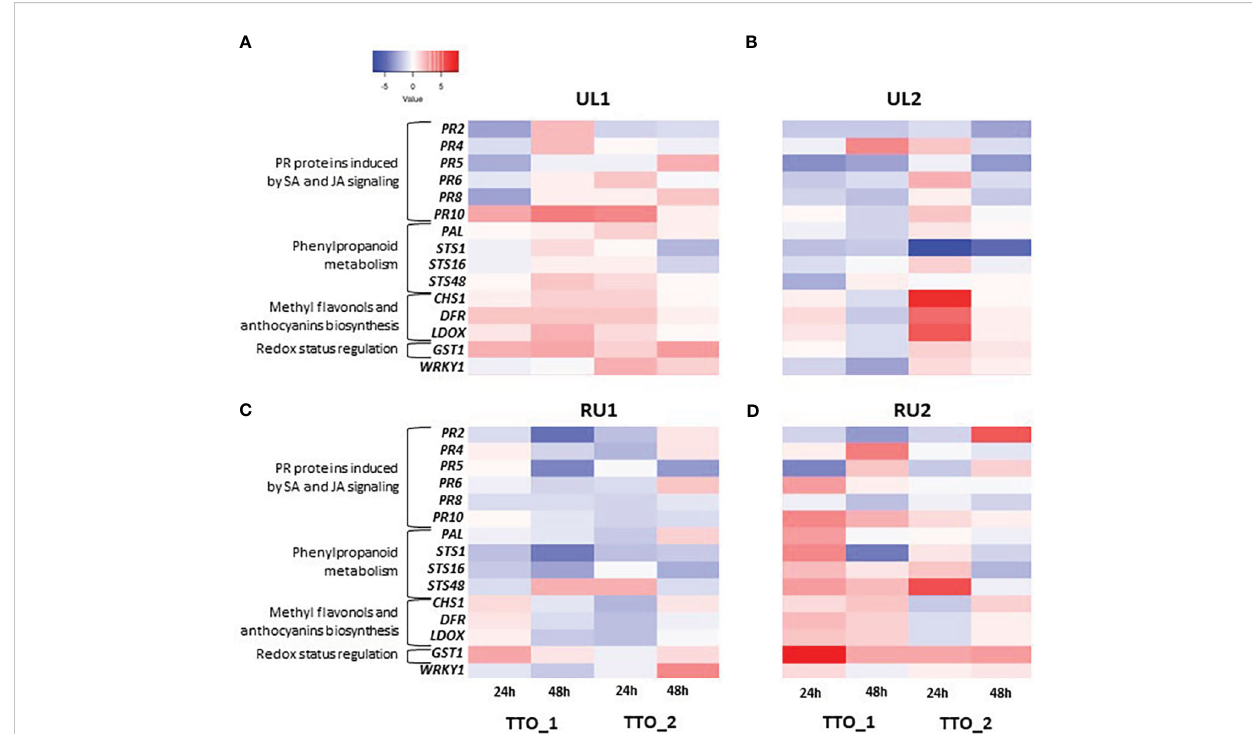
FIGURE 2 Transcript levels of defense-related genes in leaves induced by algae extract applications on grapevine plants (A) UL1; (B) UL2; (C) RU1; (D) RU2). Each column represents the sampling time, and each row represents one gene. A tree color scale was used to show fold induction of each gene (log transformed). The fold induction values were normalized to the reference genes PDC, GAPDH and COX and to water-treated leaves as the control